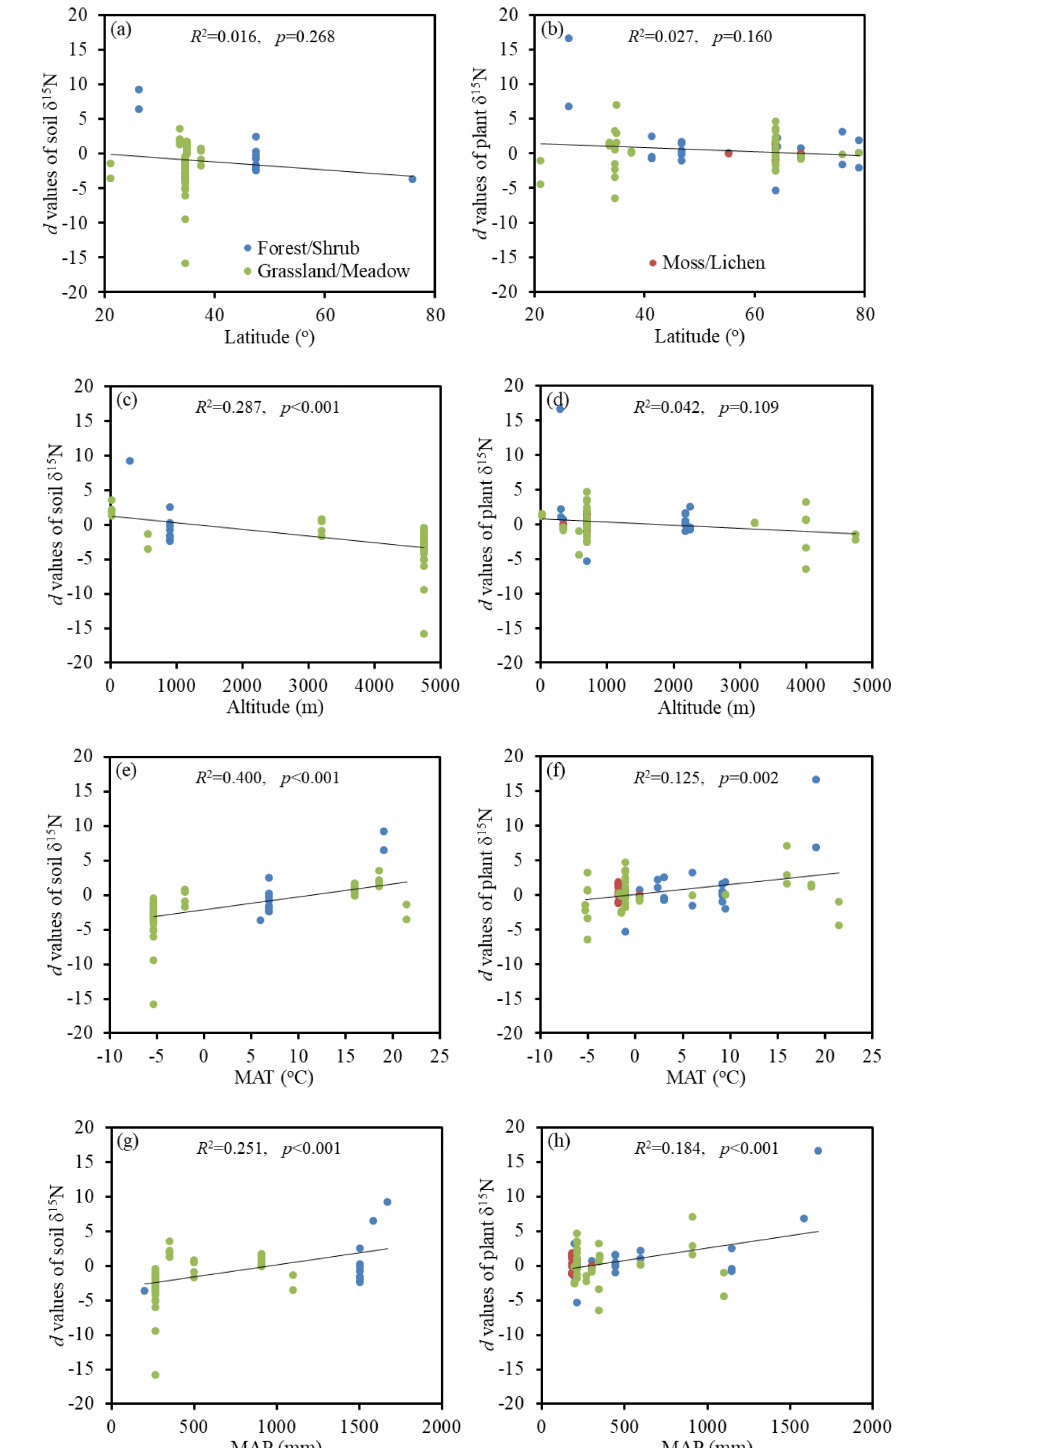
Figure 3. Relationships between the Hedges’ d values of soil and plant δ 15 N with the latitude, altitude, mean annual temperature (MAT), and mean annual precipitation (MAP) under experimental